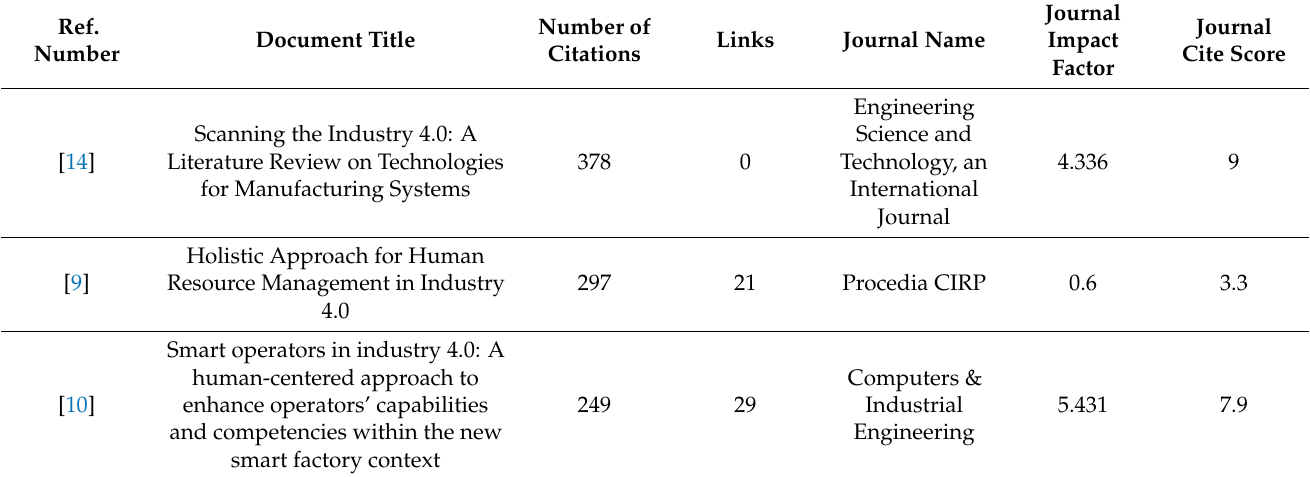
Table 1. Top twenty cited documents in relation to skills and/or competencies, training, and Industry 4.0 emerging